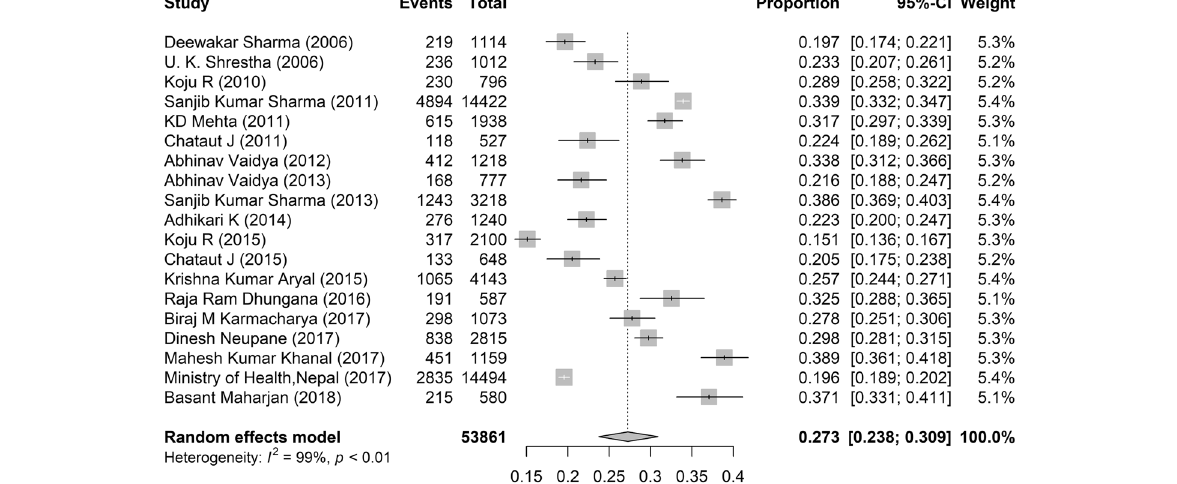
Fig. 2 Prevalence of hypertension in Nepal